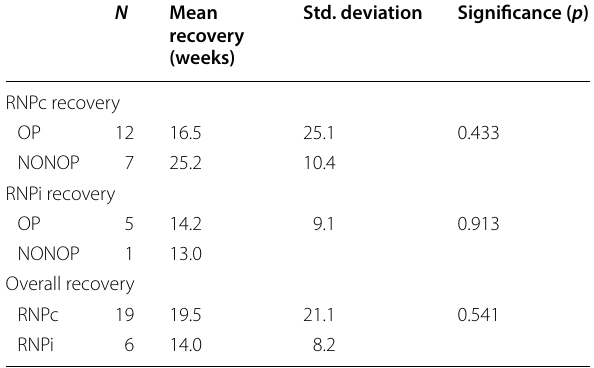
Table 2 Nerve recovery data for complete and incomplete RNP